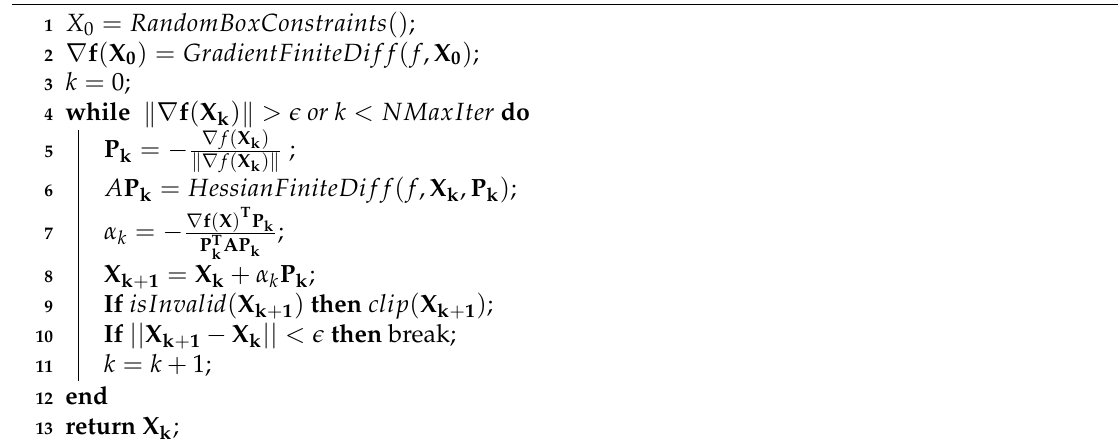
Algorithm 1: Projected Gradient Descent with maximum